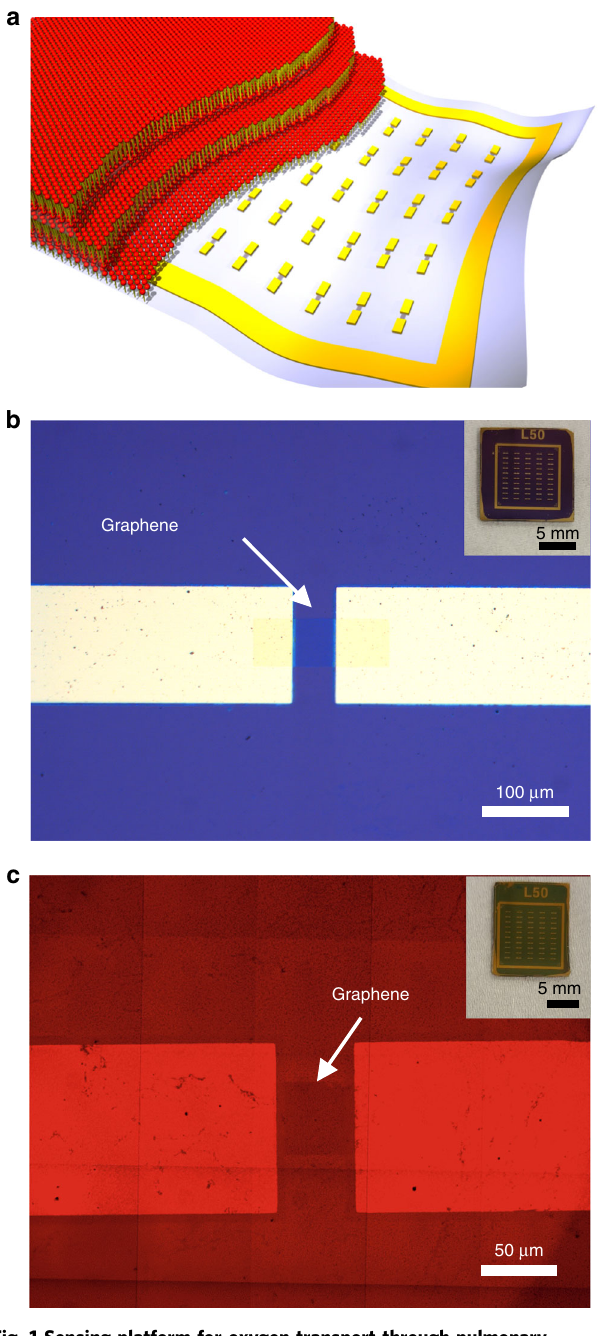
Fig. 1 Sensing platform for oxygen transport through pulmonary membranes. a Schematic illustration of lipid membranes deposited on the FET-based sensor which serves as a solid support for stacked lipid bilayers. b Bright fi eld optical microscopy image of the oxygen gas sensor. The white arrow indicates the graphene channel between gold electrodes. Channel length and width are 50 μ m. Inset: photograph of the sensor which has total 50 FETs on a 1 cm ´ 1 cm SiO 2 /Si substrate. c Fluorescence microscopy image of fl uorescently labeled lipid membranes coated on the FET sensor. Graphene is marked with a white arrow. Inset: photograph of the sensor coated with lipid fi lipid fi lms in this example are composed of a model pulmonary membrane with a 3:1 DPPC:DOPG molar ratio. Changing the composition of the lipid fi lm does not compromise sample cov- erage (Supplementary Fig. 2).